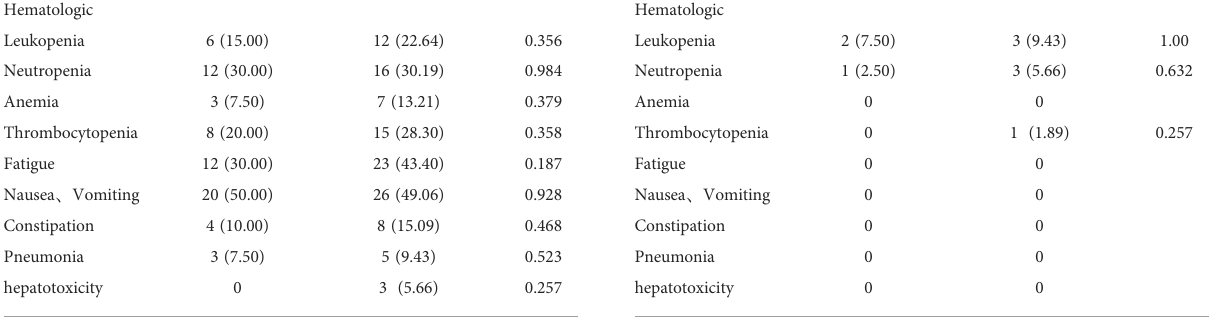
TABLE 2 Comparison of the toxicities between six-cycle treated patients and > six-cycle treated patients. Adverse events 6 cycles (n=40) >6 cycles (n=53) P value Hematologic